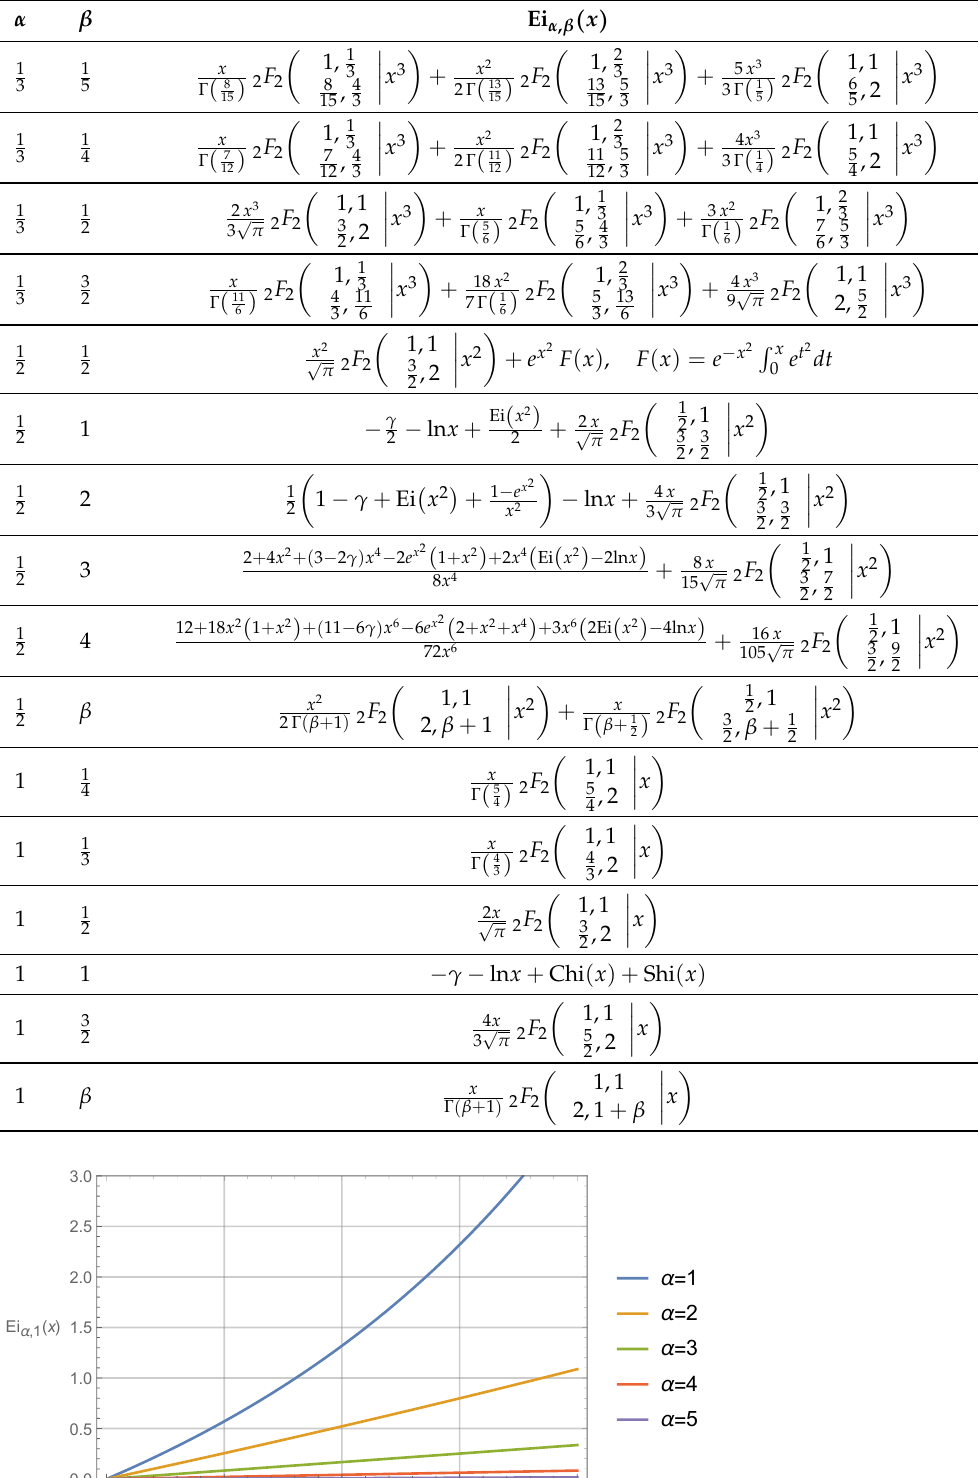
Table 1. The integral Mittag-Leffler functions derived for some values of parameters α and β by using (12).